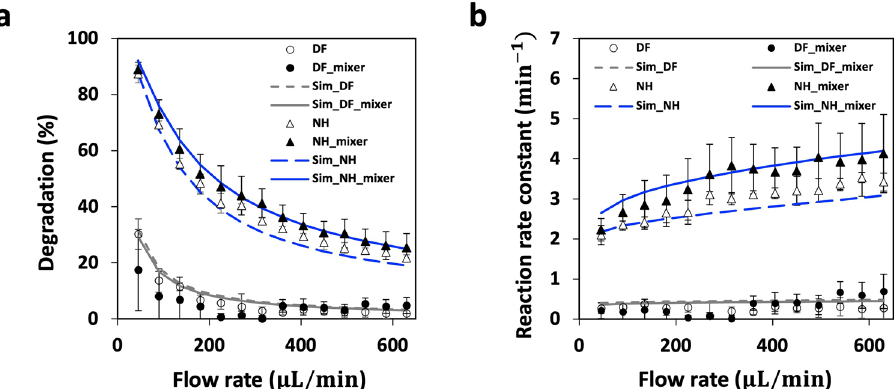
Fig. 4 Water puri fi cation capacity of DF and NH reactors when applying the herringbone micromixer. Comparison of the performance of a the Rh6G degradation and b the reaction rate constant of the DF and NH reactors at different fl ow rates. Filled markers and empty markers represent the experimental results of the microreactor covered with and without the herringbone mixer, respectively. The solid and dashed lines are the numerical simulation results. The error bars represent the standard deviations of at least ten times repeated